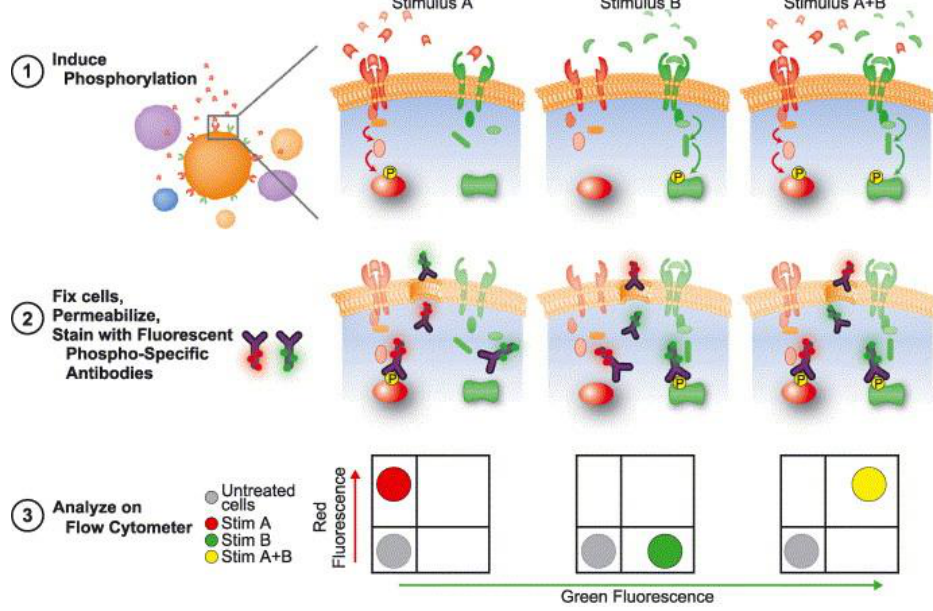
Figure 9. Phosphoflow process. Heterogeneous amples are first treated to induce phosphorylation with different stimuli, in this case A and B. Cells are then fixed, permeabilized and stained with fluorophore-conjugated phospho-specific antibodies, and further analyzed trough flow cytometry, where an increase in fluorescence signal reading is correlate with an increase in phosphorylation. Reprinted with permission from [141], Copyright (2004) Elsevier